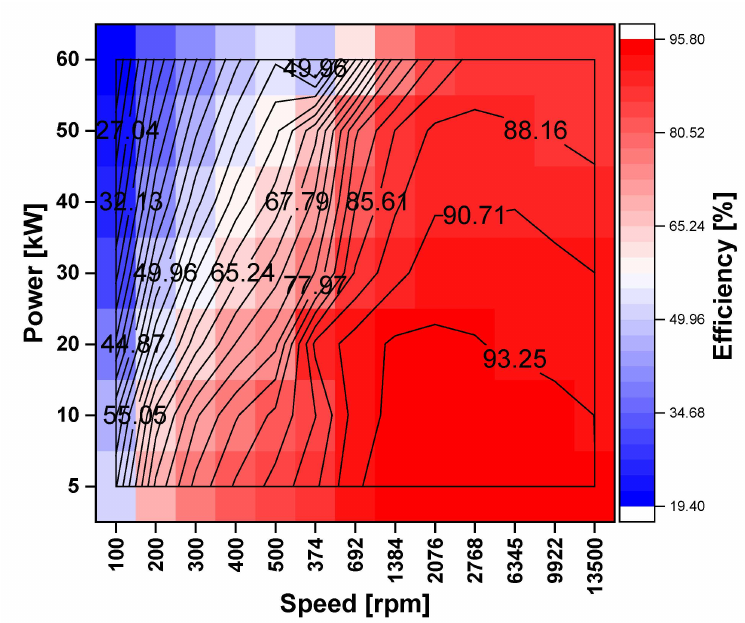
Figure 19. Efficiency